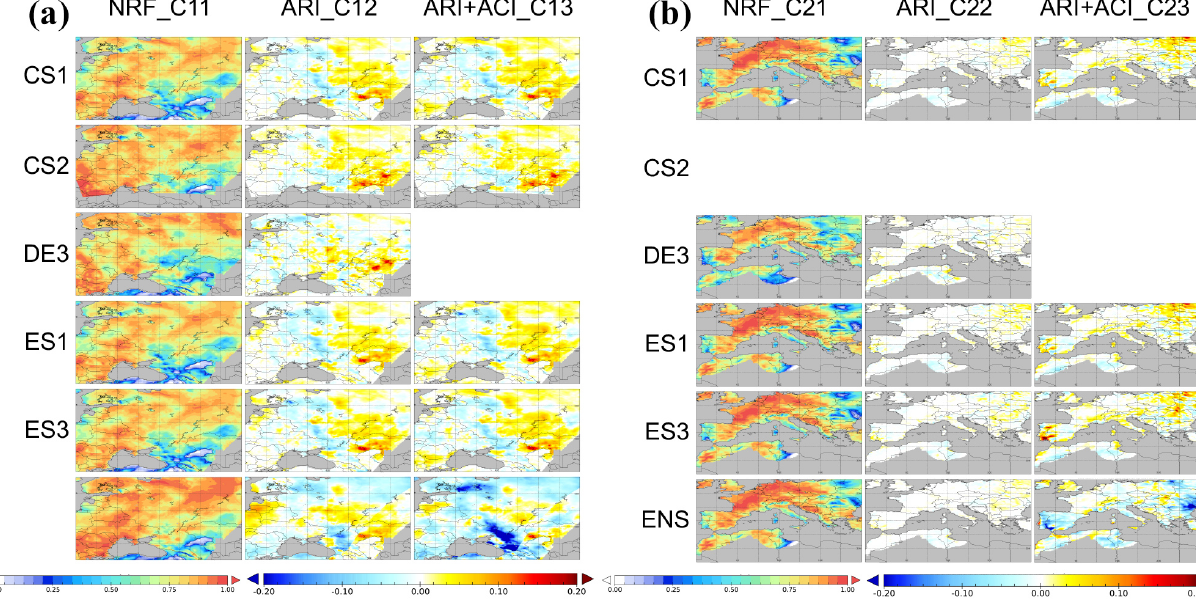
Figure 6. Time determination coefficient ( ρ 2 ) (model vs. E-OBS) of the mean temperature (TEMP) for the fire (a) and dust (b) episodes. The first column in each panel represents the value of ρ 2 of the no radiative feedback case with respect to the E-OBS database. The center and right columns indicate the increase (red values) or decrease (blue value) in each simulation with respect to the case not including